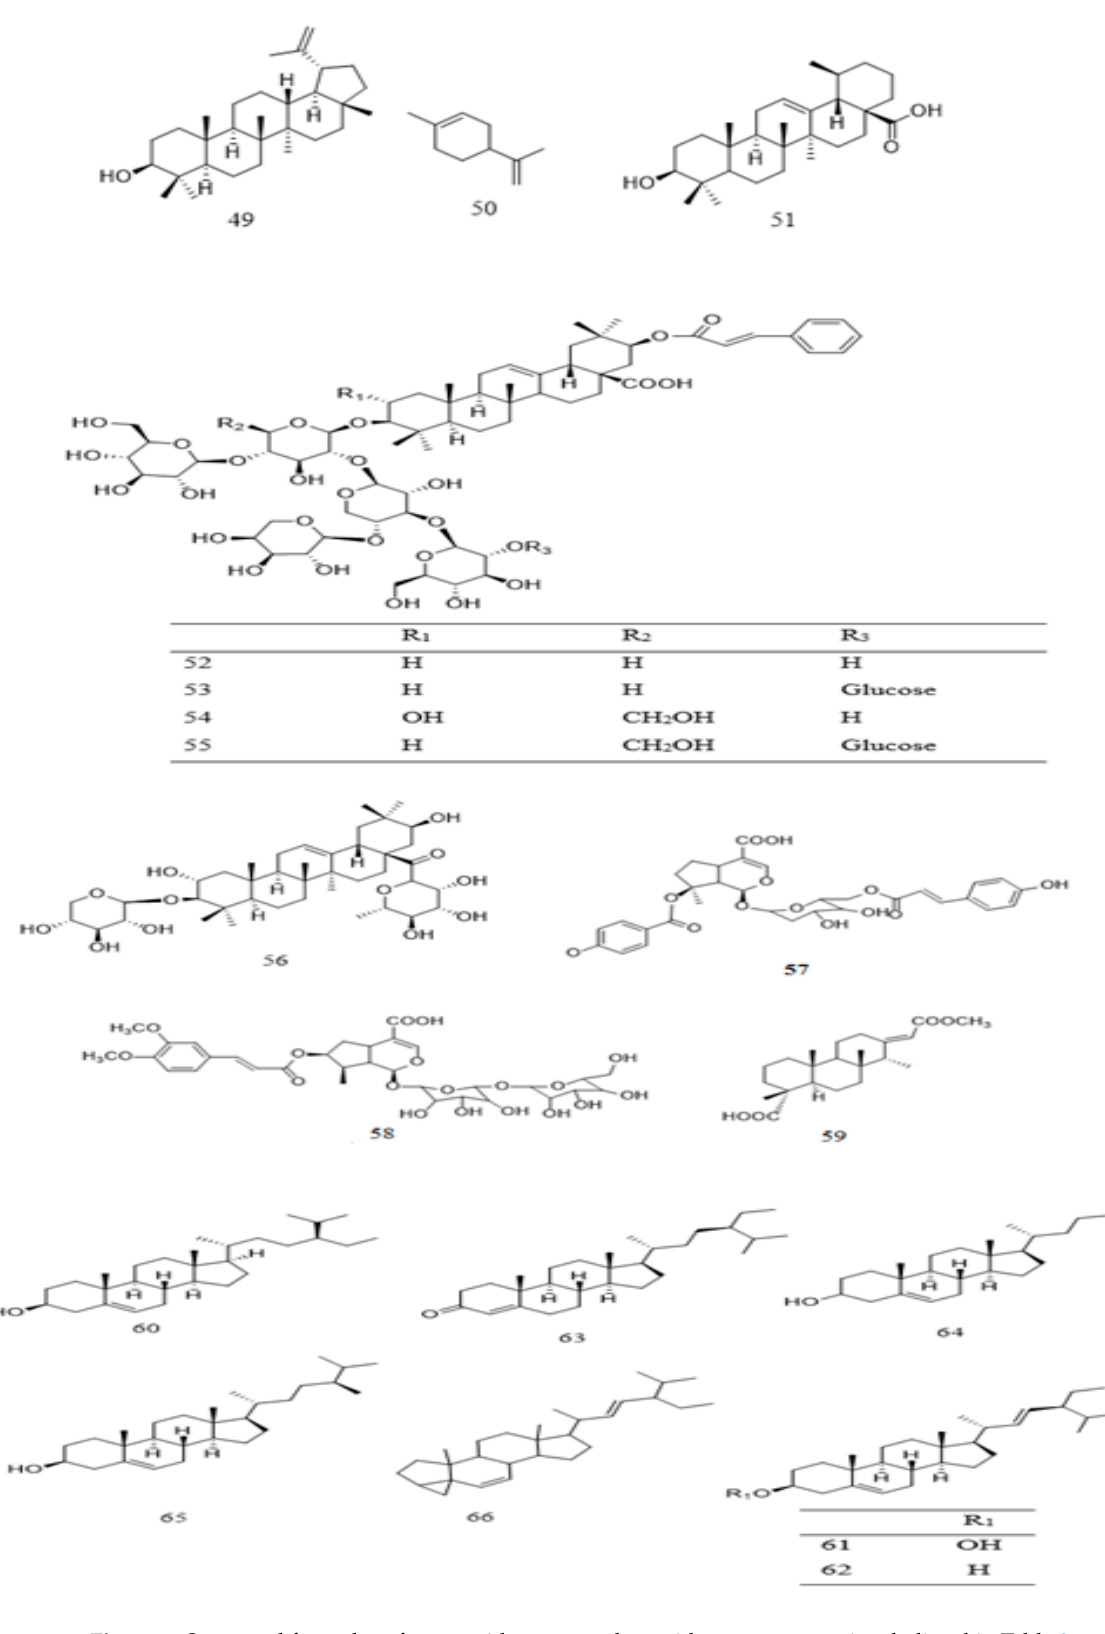
Figure 4. Structural formulas of terpenoids 49 – 59 and steroids 60 – 66 , as previously listed in Table 2.